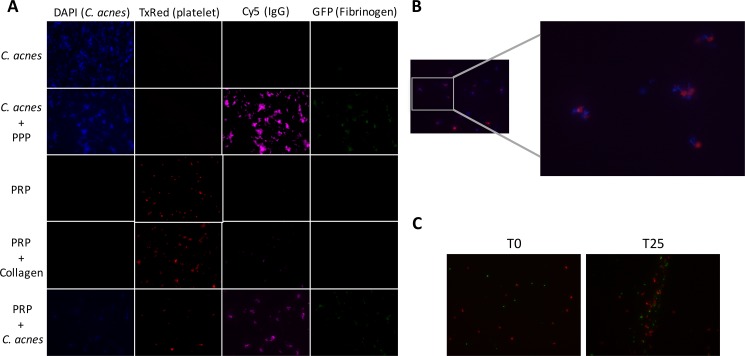
Fluorescence microscopy indicates co-localization of C. acnes and platelets.C. acnes isolate AS12 was incubated with PPP or PRP, and fluorescent probes against the bacterium (DAPI), platelets (TxRed; Alexa Fluor 594), IgG (Cy5; Alexa Fluor 647), and fibrinogen (GFP; FITC), used to visualize the presence and localization of targets. PBS, PPP and PRP alone were used as negative controls, and collagen I as a positive control for platelet aggregation (A). Co-localization of C. acnes and platelets was analyzed by merging the signal for DAPI (C. acnes) and TxRed (platelets) (B). The co-localization of C. acnes (Oregon Green) and platelets (TxRed) after 25 minutes (T25) and at starting point (T0) was compared and analyzed using Pearson's correlation (p = 0.017)(C). All micrographs are at 40x magnification.